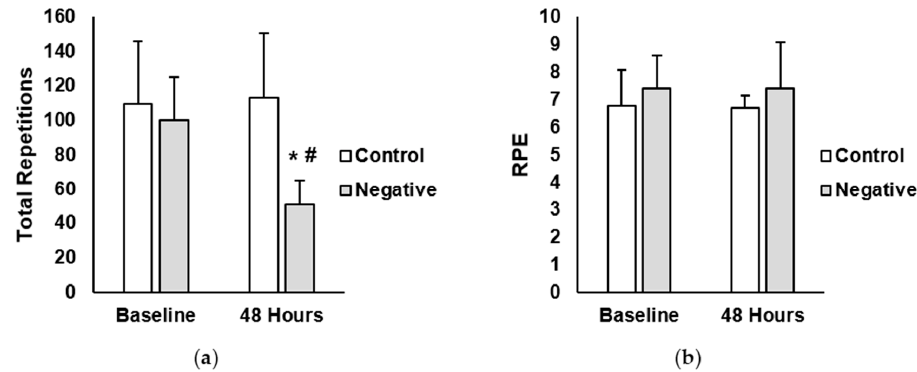
Figure 2. ( a ) Total repetitions completed in the control and negative ‐ belief (negative) groups at baseline and 48 h after the soreness exercise protocol ( b ) Average rate of perceived exertion (RPE) in the control and negative ‐ belief (negative) groups at baseline and 48 h after the soreness exercise protocol. Data are presented as mean ± SD. * indicates significantly different from baseline, # indicates significantly different from control ( p < 0.05).